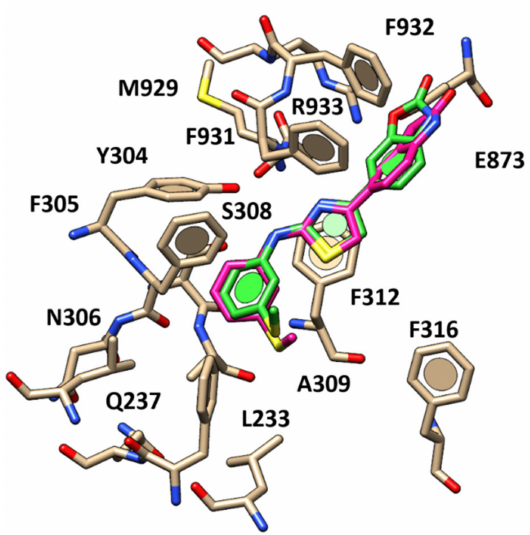
Figure 12. Docking positioning of compound 84 ( C atom; green) and 89 ( C atom; magenta) within the X-ray crystallographic structure of the human